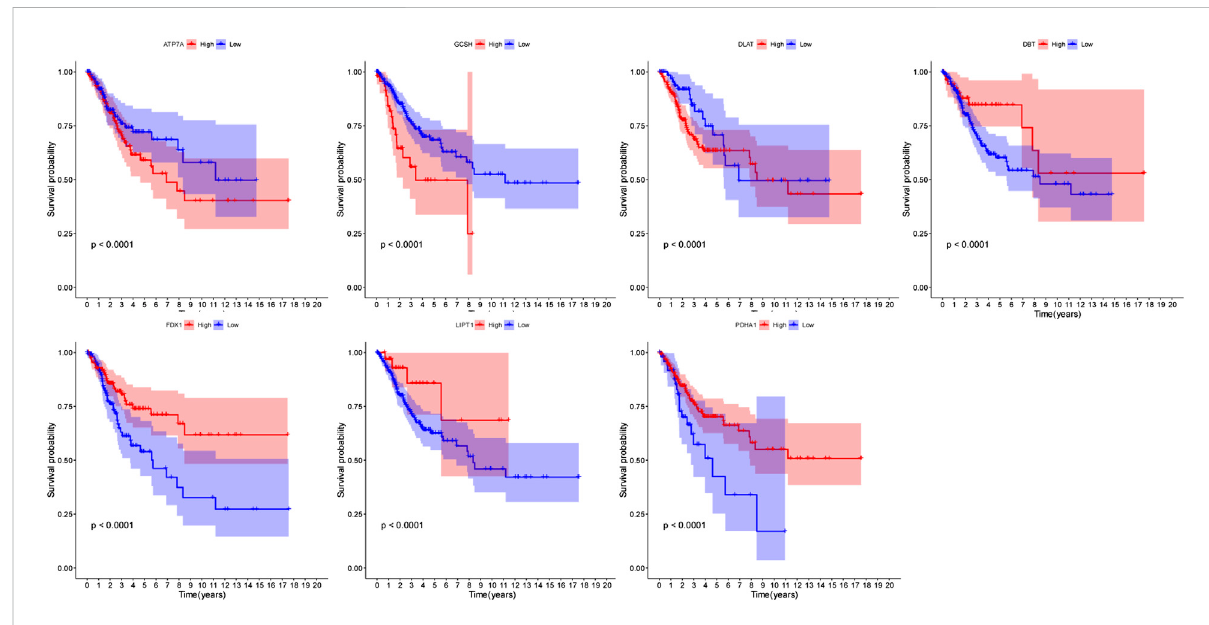
FIGURE 5 Kaplan – Meier survival analyses for each cuproptosis-related gene of the prognostic